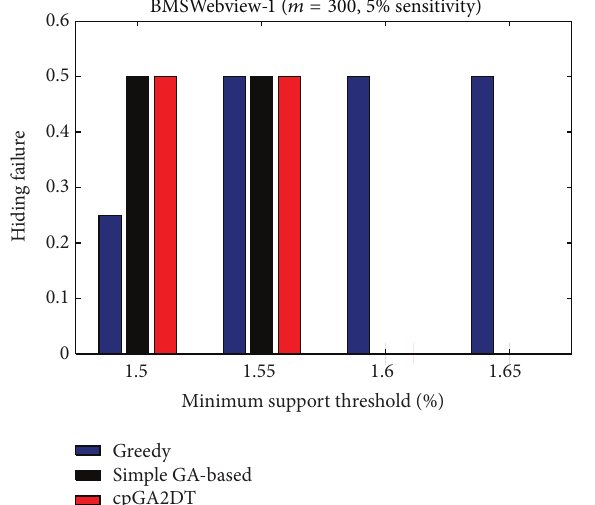
Figure 19: Comparisons of missing cost at various sensitivity percentages of frequent itemsets for BMSWebview-1 database.